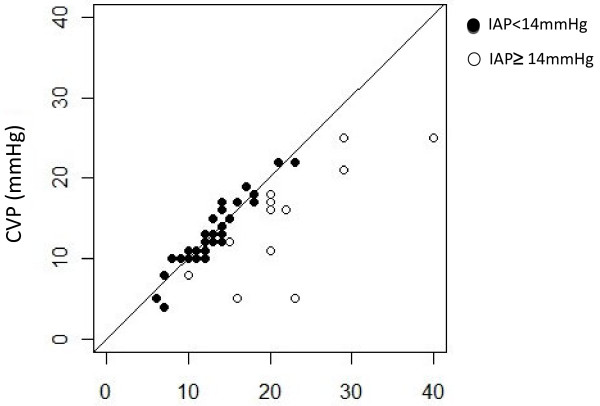
Less than 14 mmHg (black circle) FIVP reflected CVP, the linear regression equation was CVP = 1.01 FIVP. Greater than 14 mmHg (white circle), FIVP overestimated CVP. FIVP, femoroiliac venous pressure; CVP, central venous pressure.